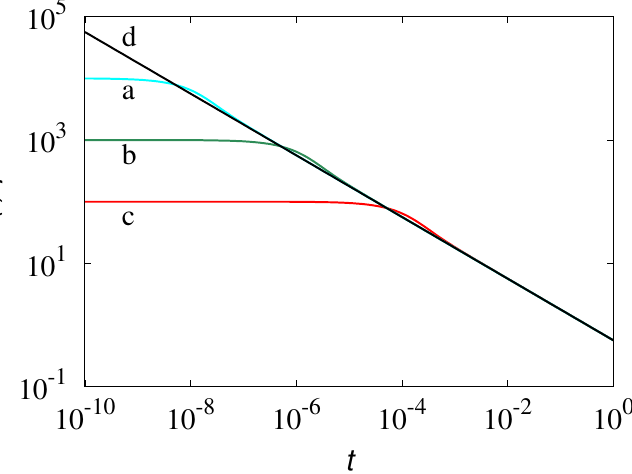
Figure 2. Rescaled inertial kernel k ( t ) / β , Equation (41) vs t for a simple Maxwell fluid, characterized by the relaxation time θ c . Lines (a) to (c) refer to θ c = 10 − 4 , 10 − 6 , 10 − 8 , respectively. Line (d) depicts the asymptotic nondimensional Basset curve, k ( t ) / β = 1/